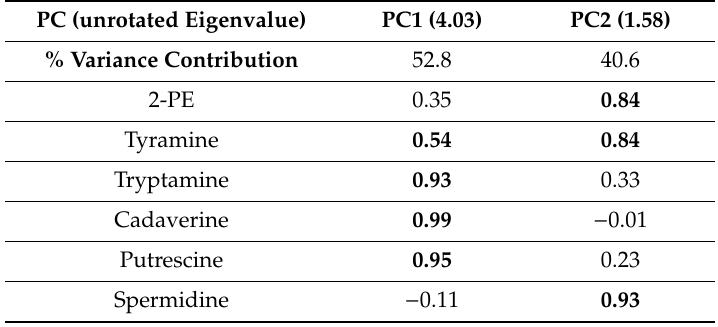
Table 6. PCA loadings vectors for FCLO BAs in a two PC-limited PCA model performed with varimax rotation and Kaiser normalization. Percentage variance contributions for these PCs and their (unrotated) analysis eigenvalues are also listed. Bold numbers are for a purpose specified in the Figure